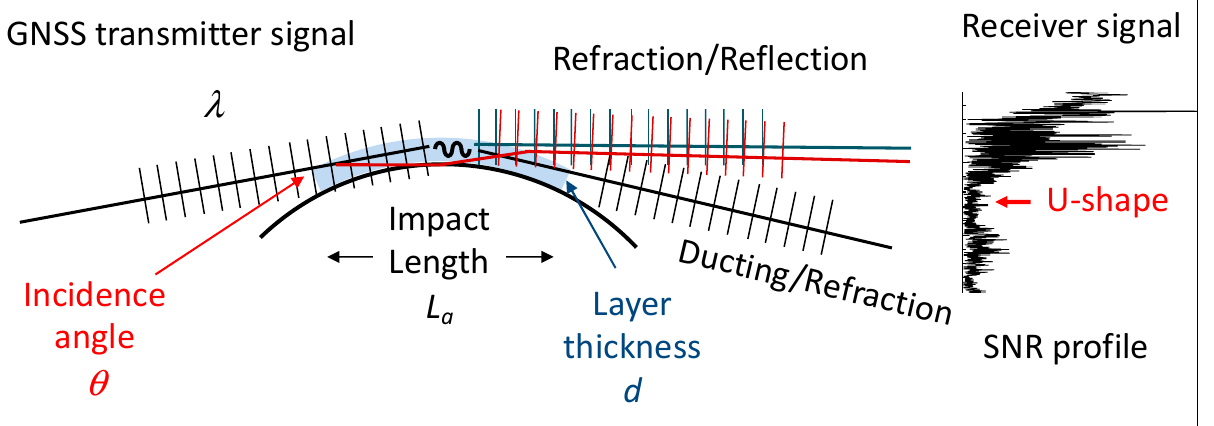
Figure 3. Schematic diagram of GNSS-RO wave optics as refracted by an atmospheric layer and reflected by the surface in multi-path interference.